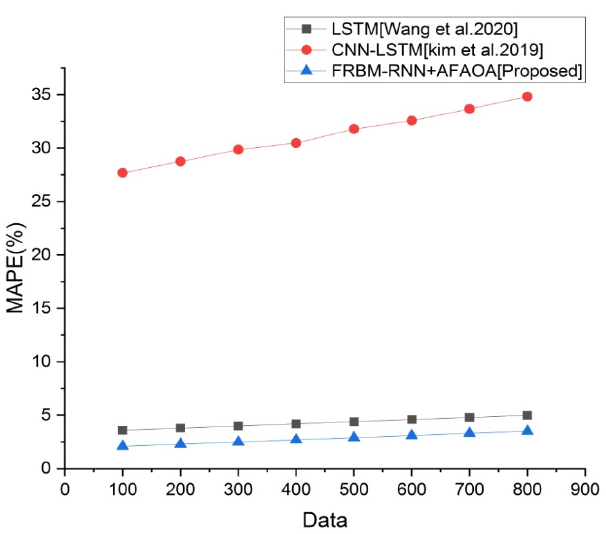
Figure 7. Graphical analysis of different methods based on MAE [Source: Author].